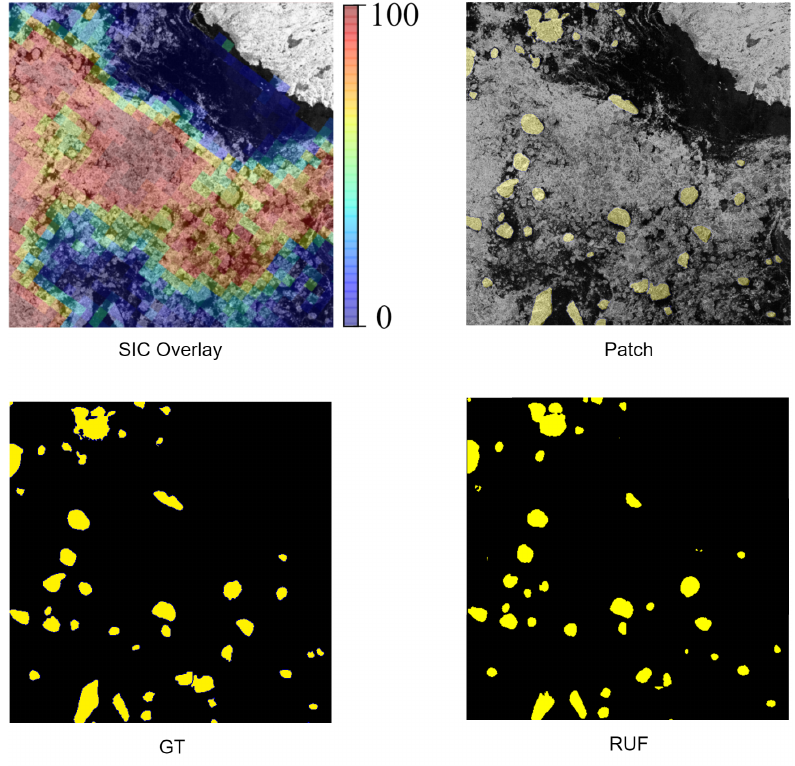
Figure 9. Zoom-in on the segmentation result of a patch. Here, Patch and GT denote original image patch input and ground truth, respectively, where GT are the floes that were annotated manually according to our selection criteria. The sea ice concentration (SIC) mask is overlaid on the patch for comparison between sea ice as a continuous (passive microwave data) vs. discrete (processed ice floe masks from SAR)